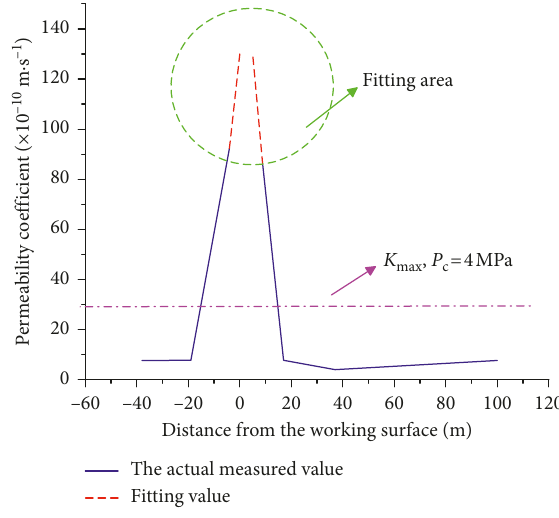
Figure 11: Sandstone permeability variation rules with theoretical computing of confining Table 1: Permeability classification of rock-soil bodies.